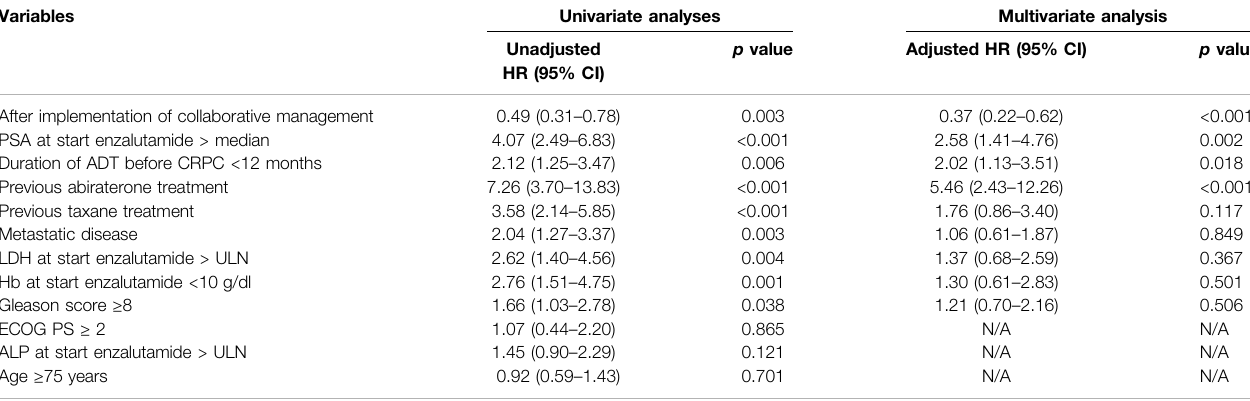
TABLE 3 | Univariate and multivariate Cox proportional hazard models for time to PSA progression from the initiation of